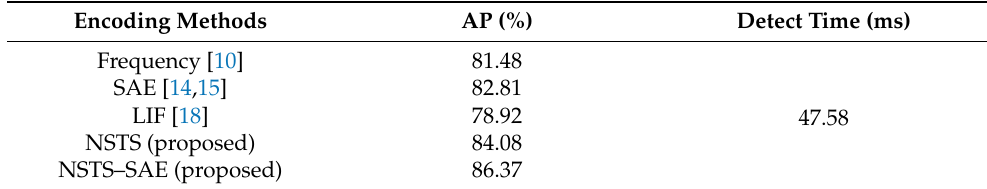
Table 2. The performance comparison of different event-to-frame encoding methods evaluated by the event-based detector (EBD) (IOU0.5 AP).